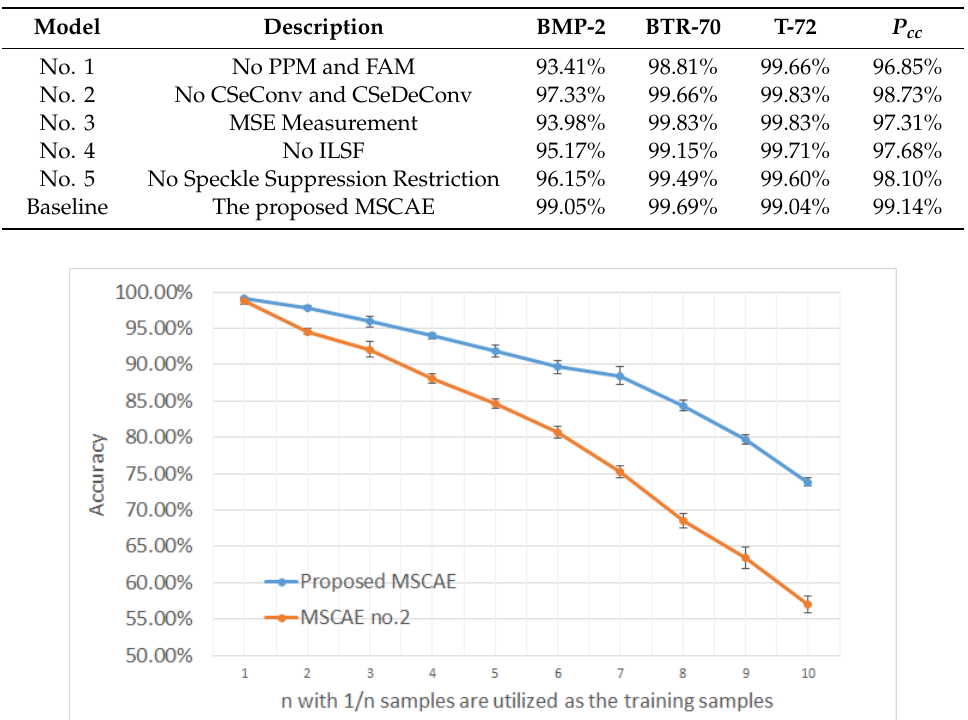
Table 5. Validation of the components in the proposed MSCAE model.